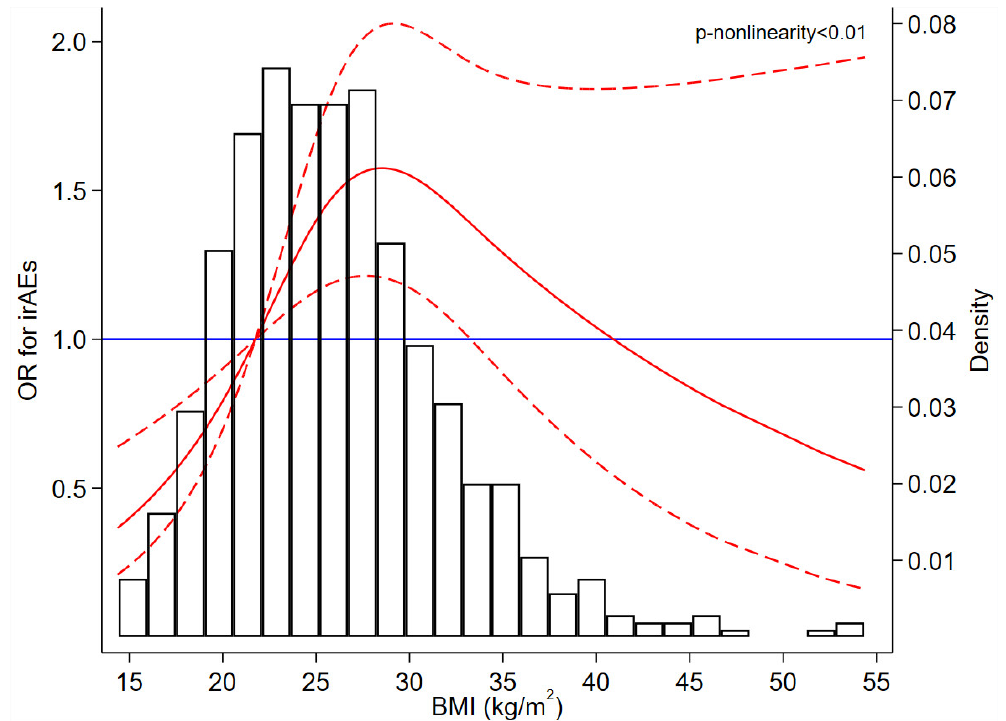
Figure 2. Plot depicting the distribution of pre-treatment BMI and the dose–response relationship between pre-treatment BMI and irAEs. BMI = 21.8 was treated as a reference in the dose-response curve. The solid red line is the fitted line, red dash lines are 95% confidence intervals of OR, and the blue solid line is the reference line. Abbreviations: BMI: body mass index, irAEs: immune-related adverse events, OR: odds ratio. Table 3. Association of pre-treatment BMI ( ≥ 25 vs. <25 kg/m 2 ) with irAEs in subgroups.